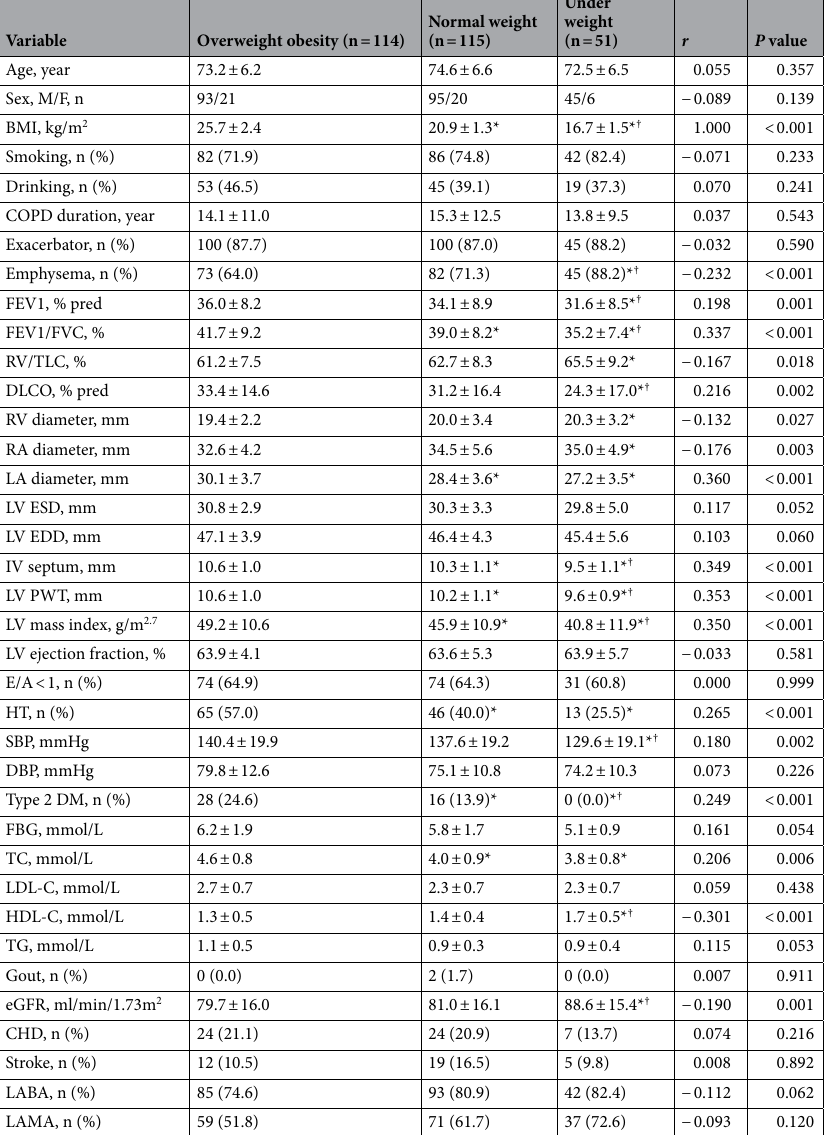
Table 2. Comparison of clinical parameters among different BMI categories and correlations in patients with severe COPD (n = 280). Values presented as mean ± SD or n (%).* p < 0.05 versus Overweight obesity group; † p < 0.05 versus Normal weight group. COPD, chronic obstructive pulmonary disease; BMI, body mass index; FEV1, forced expiratory volume in one second; FVC, forced vital capacity; RV, residual volume; TLC, total lung capacity; DLCO, diffusing capacity of carbon monoxide; RV, right ventricular; RA, right atrial; LA, left atrial; LV ESD, left ventricular end-systolic diameter; LV EDD, left ventricular end-diastolic diameter; IV, interventricular; LV PWT, left ventricular posterior wall thickness; LV, left ventricular; E/A: transmitral peak early (E) and late (A) filling velocity ratio; HT, hypertension; SBP, systolic blood pressure; DBP, diastolic blood pressure; DM, diabetes mellitus; FPG, fast plasma glucose; TC, total cholesterol; LDL-C, low density lipoprotein cholesterol; HDL-C, high density lipoprotein cholesterol; TG, triglyceride; eGFR, estimated glomerular filtration rate; CHD, coronary heart disease; LABA, Long-acting β2 adrenergic receptor agonist; LAMA, Long-acting muscarinic